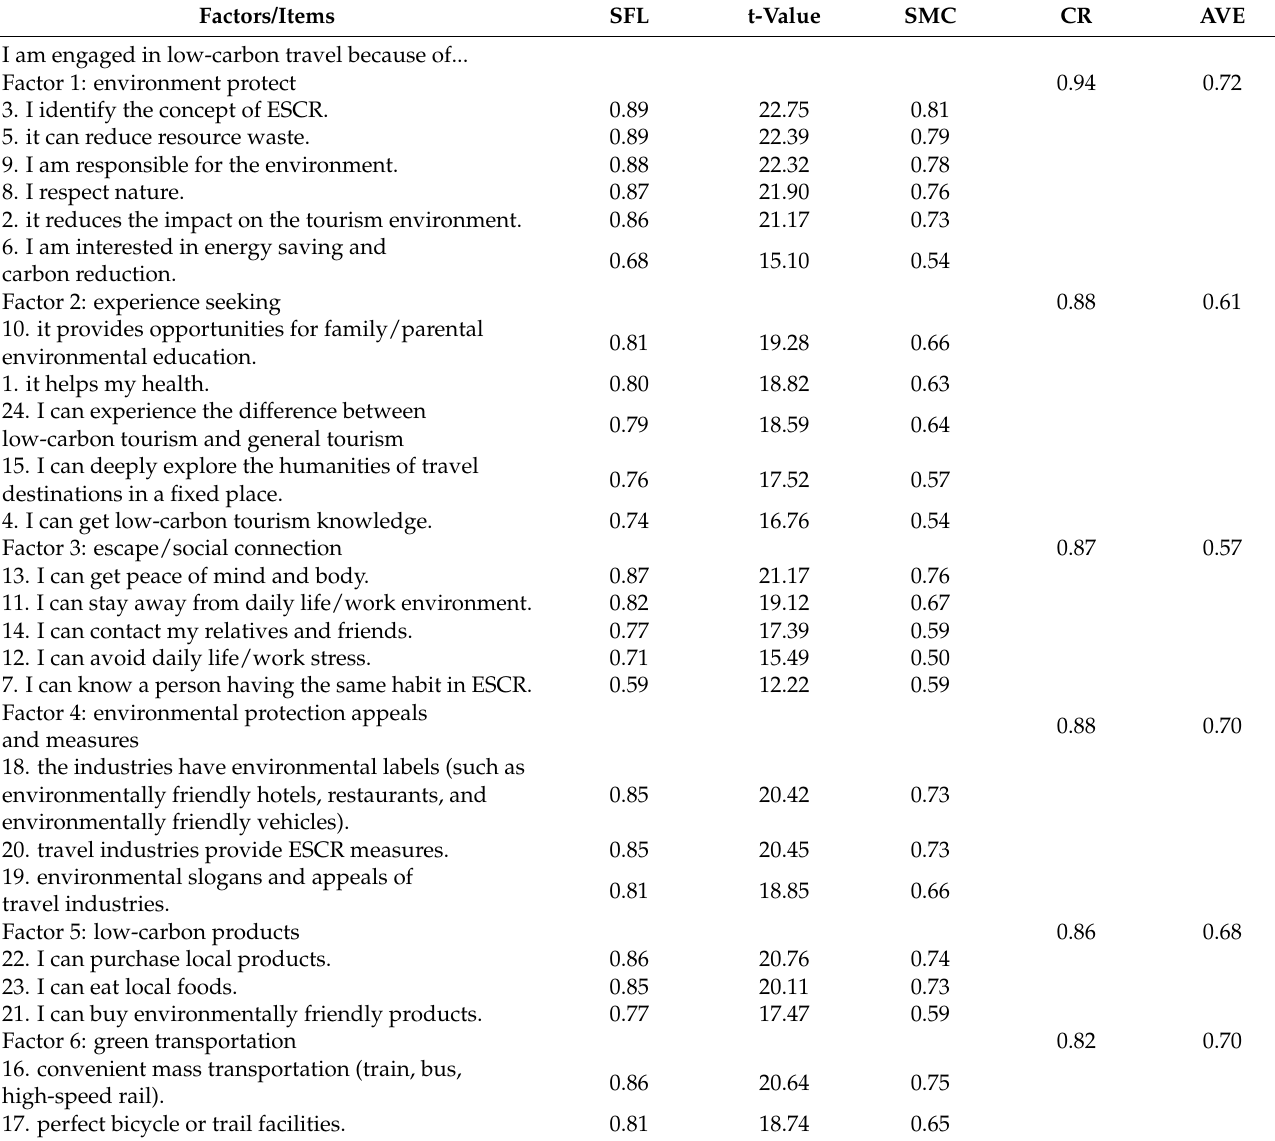
Table 5. CFA results of LCTMS—sample from non-low-carbon destinations ( n = 390). Factors/Items SFL t-Value SMC CR